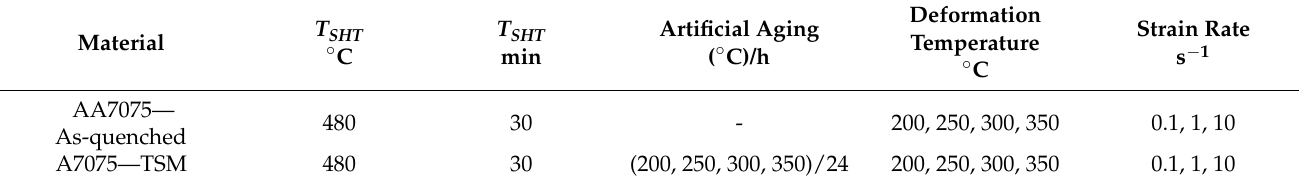
Table 2. Main experimental parameters used in this